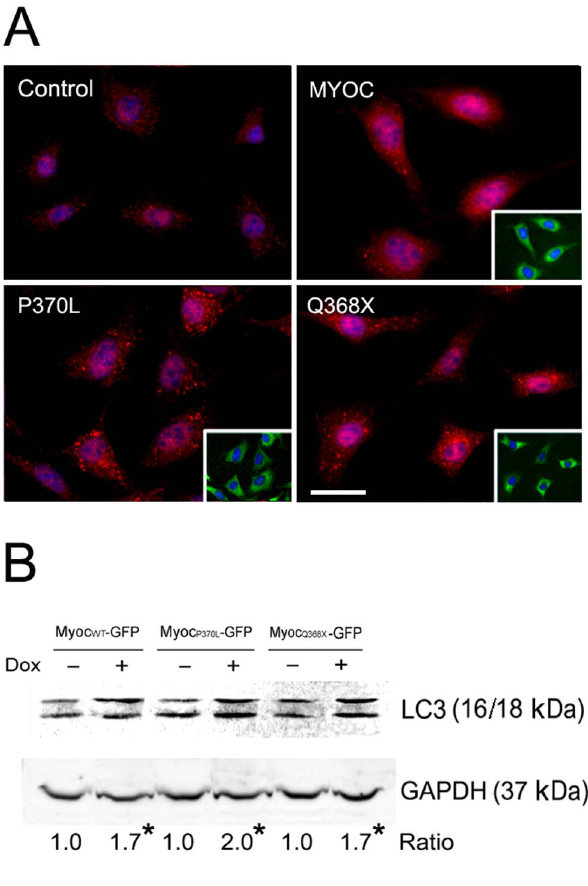
Figure 7. PSMB5 levels in inducible cells. A . PSMB5 immunostain- ing (in red) in inducible, stable RGC5 cells. The cells were induced by Dox for 24 h to express moderate levels of myocilin WT -GFP (MYOC), myocilin P370L -GFP (P370L) or myocilin Q368X -GFP (Q368X). The fusion protein-expressing, green fluorescent cells are shown in insets. There was no green fluorescence, as expected, in non-induced control cells. Note a reduced PSMB5 staining intensity in myocilin-GFP-expressing green cells compared with non-induced cells. Scale bar, 10 m m. B . Western blotting for PSMB5 protein level. RGC5 cells were induced for 24 h to express myocilin WT (Myoc WT )-, myocilin P370L (Myoc P370L )-, and myocilin Q368X (Myoc Q368X )-GFP. Total cell lysate was subject to SDS- PAGE and immunoblotting using anti-PSMB5 or anti-GAPDH. The PSMB5/GAPDH ratios in induced cells relative those of non-induced controls are presented. *, P , 0.002 compared to non-induced controls. All experiments were repeated at least 3 times, yielding similar results. doi:10.1371/journal.pone.0092845.g007 were transferred to nitrocellulose membrane and the level of endogenous myocilin was assessed by Western blotting using monoclonal anti-myocilin antibody 1.1 [44] (a generous gift from Dr. Michael Fautsch, Mayo Clinic). The membrane was also immunoblotted with polyclonal anti-GAPDH (1:5000, Trevigen, Gaithersburg, MD) for loading control. For turnover of b -catenin, rabbit anti- b -catenin polyclonal antibody (Santa Cruz Biotech- nology, Dallas, Texas) was used. Immunoreactive protein bands were detected by chemiluminescence using SuperSignal Substrate (Pierce). Densitometry was performed. The band intensity of the endogenous myocilin and b -catenin was normalized to that of GAPDH. The myocilin/GAPDH or b -catenin/GAPDH ratios determined were plotted against time points. The polynomial